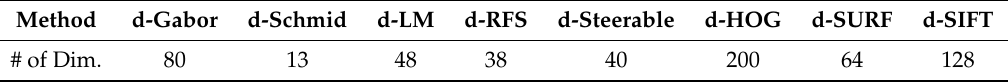
Table 1. Number of dimensions (Dim.) of the dense